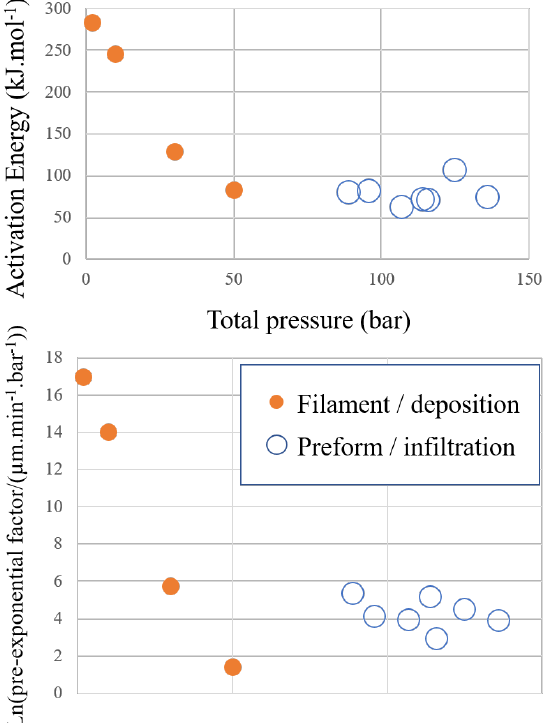
Figure 15. Kinetic parameters vs. total pressure in CVD and CVI experiments. The size of the symbols indicates the experimental